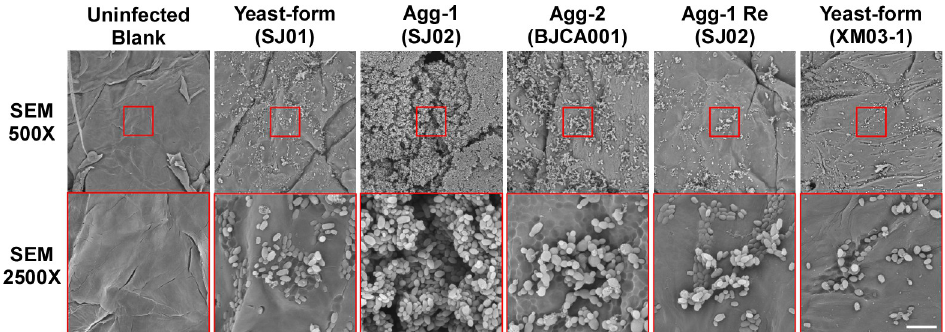
Fig 5. Skin infection assays using a newborn mouse model. C . auris strains: nonaggregative/yeast-form (SJ01), Agg-1 (SJ02), Agg-2 (BJCA001A), Agg-1Re (SJ02Re), and nonaggregative/yeast-form XM03-1. Approximately 5 x 10 6 C . auris cells of each strain in 2 μ L ddH 2 O were inoculated on the dorsal back skin of newborn mice. After the skin surface dried, a small sterilized glossy paper was affixed on the inoculated spot with medical tape. After 24 hours of infection, the infected skin areas were excised and gently washed with 1 x PBS. Low and high magnification SEM images are shown. Scale bar, 10 μ m.